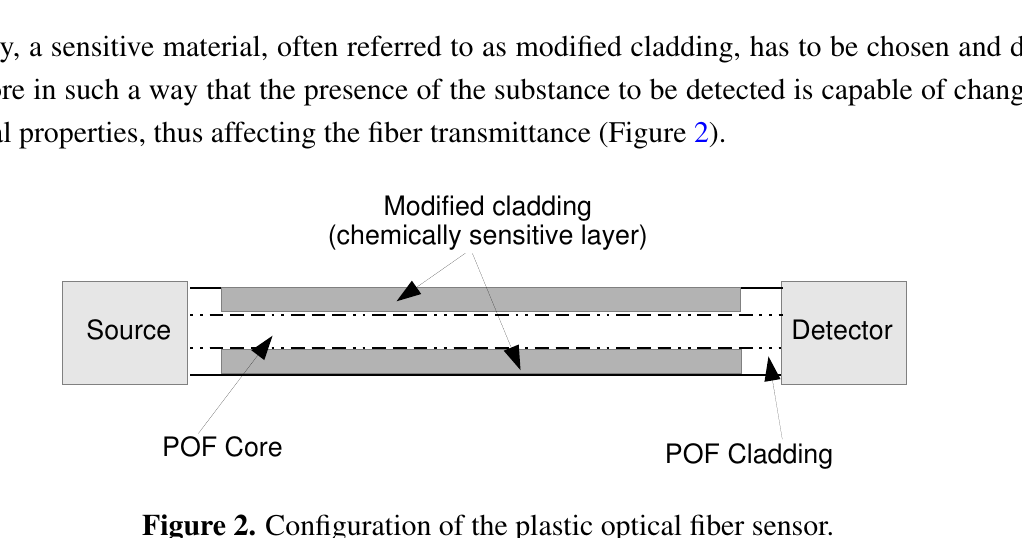
Figure 1. Plastic optical fiber structure (not to scale).